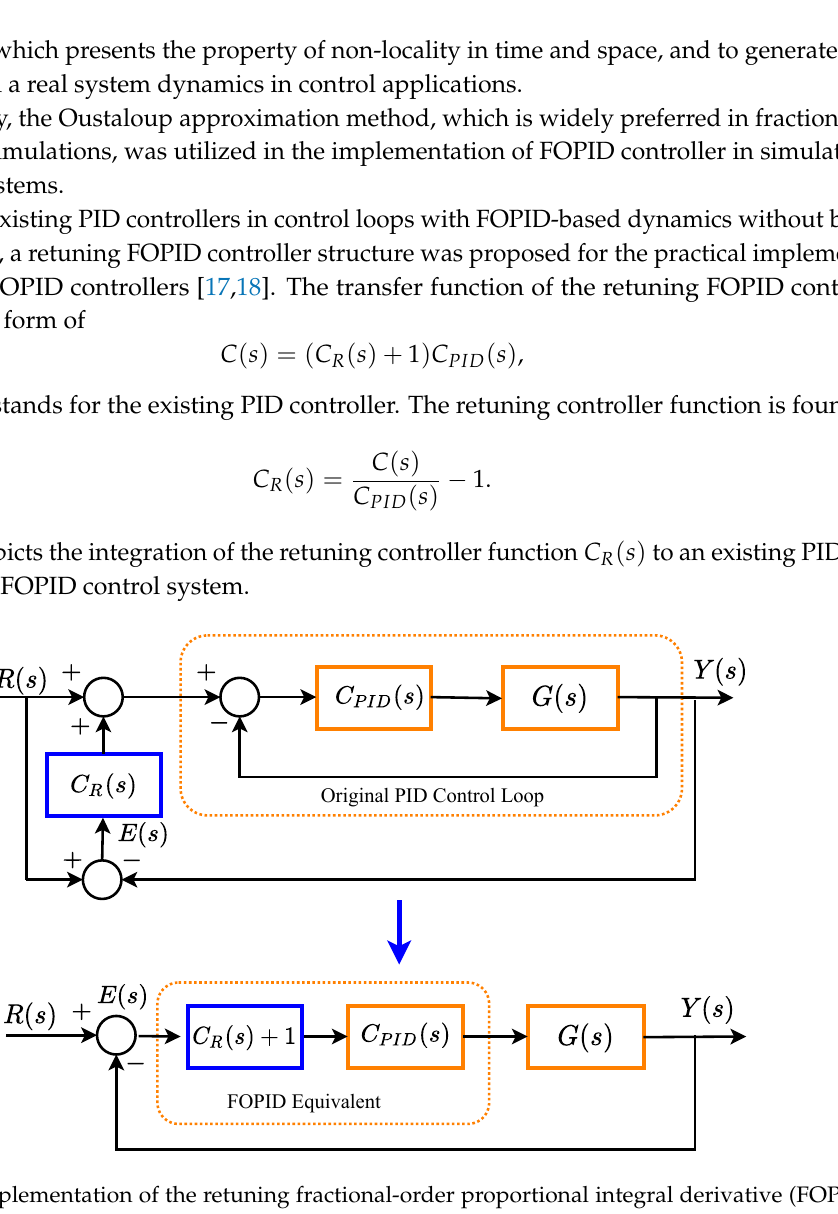
Figure 1. Implementation of the retuning fractional-order proportional integral derivative (FOPID) system by using the PID control loop